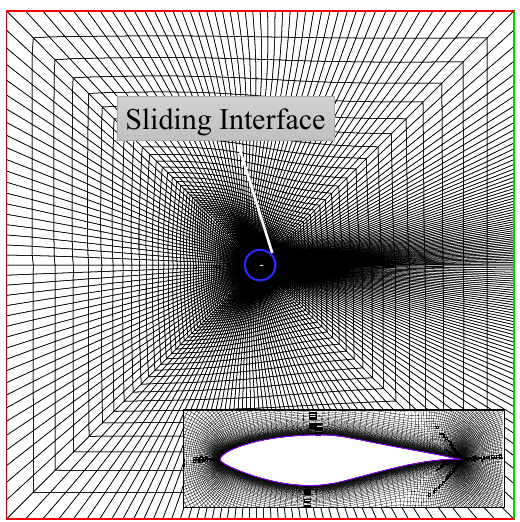
Figure 3. Computational mesh and boundary layer grids. The red line denotes the velocity inlet boundary, and the green line denotes the pressure outlet boundary.